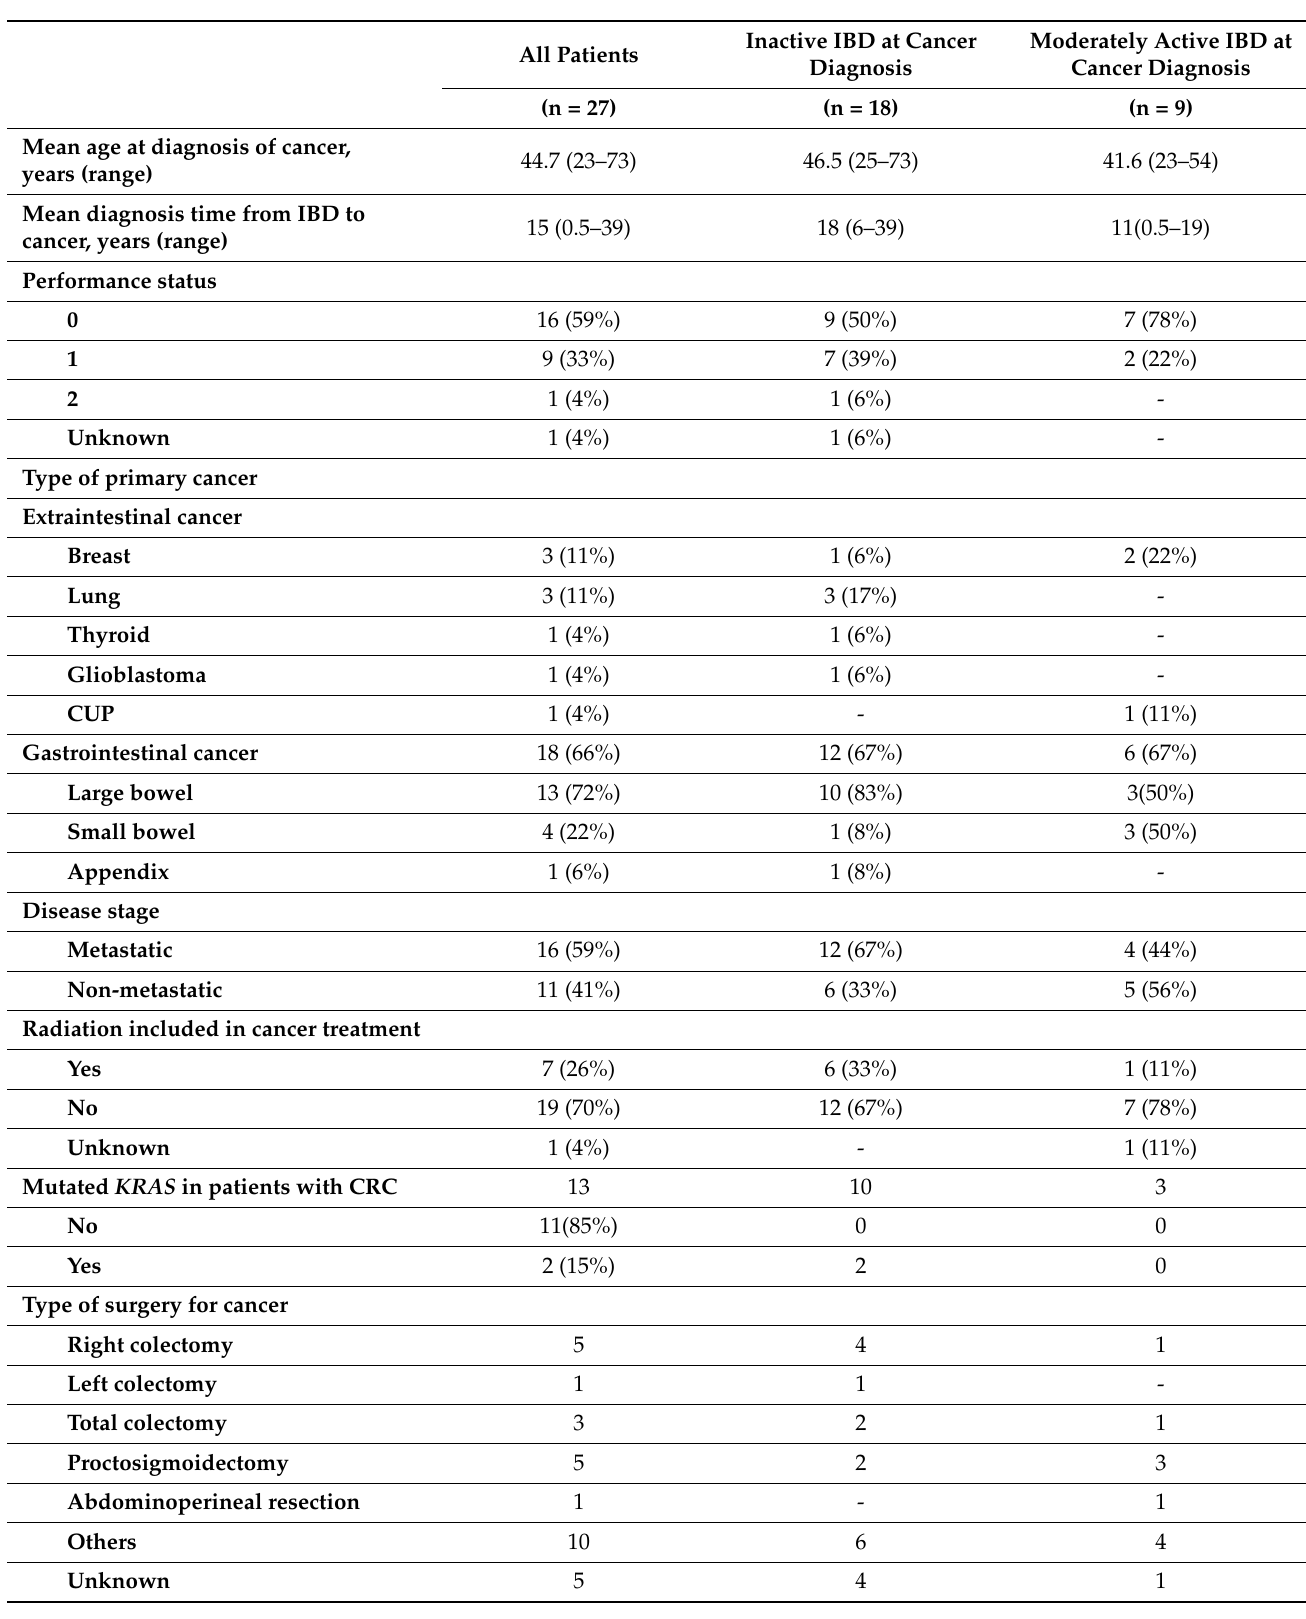
Table 2. Characteristics of cancer and cancer surgery at diagnosis; CUP: carcinoma unknown primary; * type of chemotherapy with bevacizumab in first or second line; ** 5FU: 5-fluorouracil; *** lomustine and